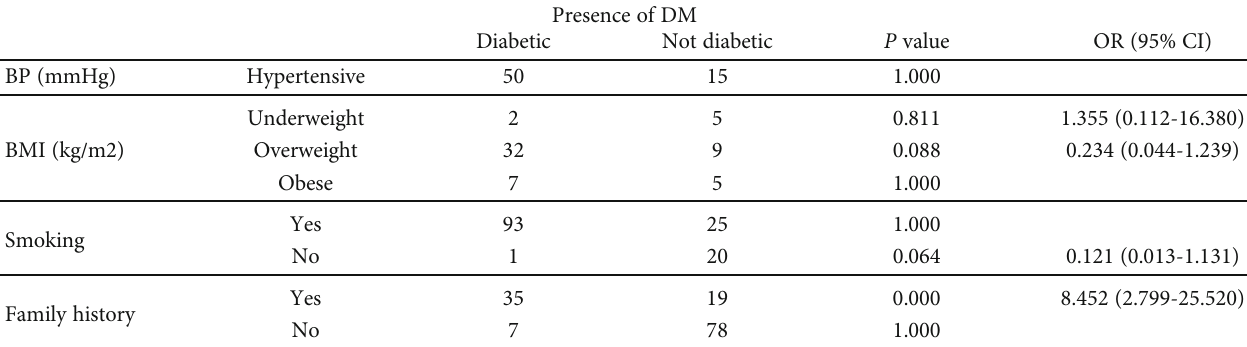
Table 2: Multivariate analysis of risk factors associated with type 2